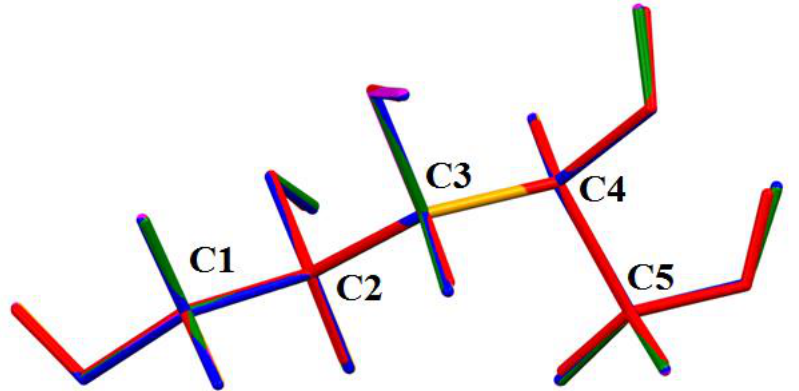
Figure 4. Overlay of all xylitol structures deposited in CSD. Xylitol structures were marked as red (XYLTOL), blue (XYLTOL01), orange (XYLTOL02), magenta (XYLTOL03), and green (XYLTOL04).